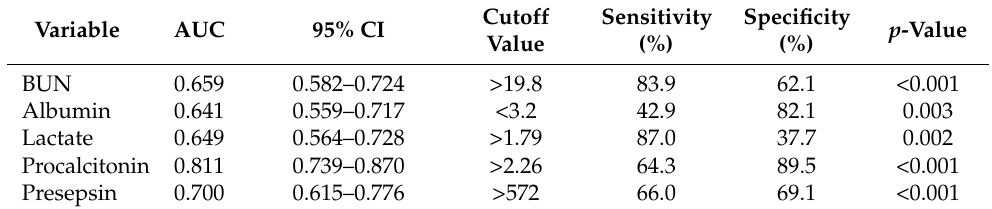
Table 4. The value of laboratory biomarkers for predicting AKI in patients with COVID-19.